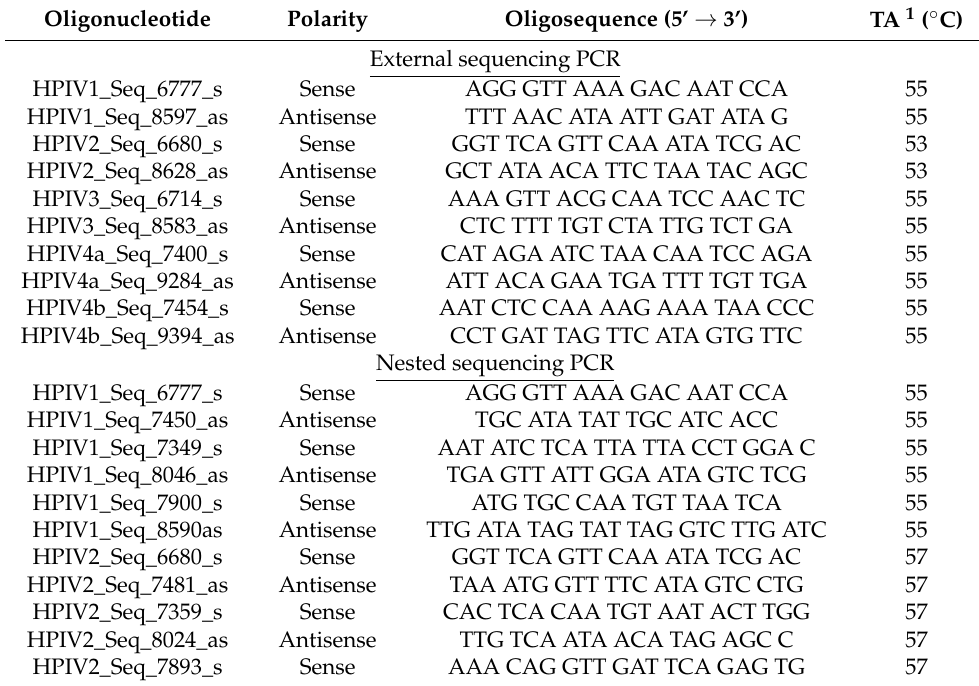
Table 1. Oligonucleotides for sequencing and differentiating HPIV